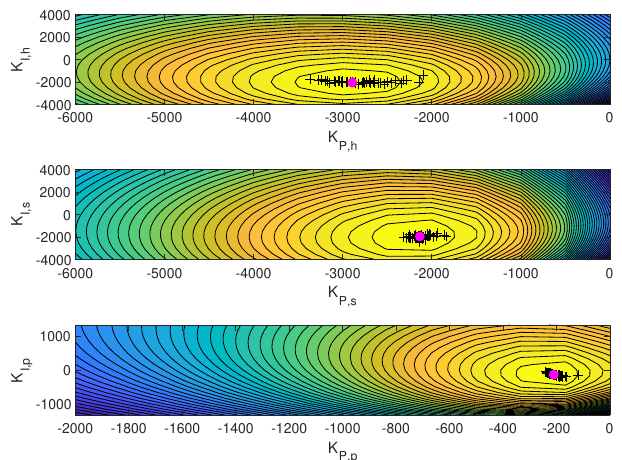
Fig. 11: The P abs surface, shown with fifty realizations of impedance model Z error with 20% uncertainties on inertia, spring, and damping terms for sea-state 10A.